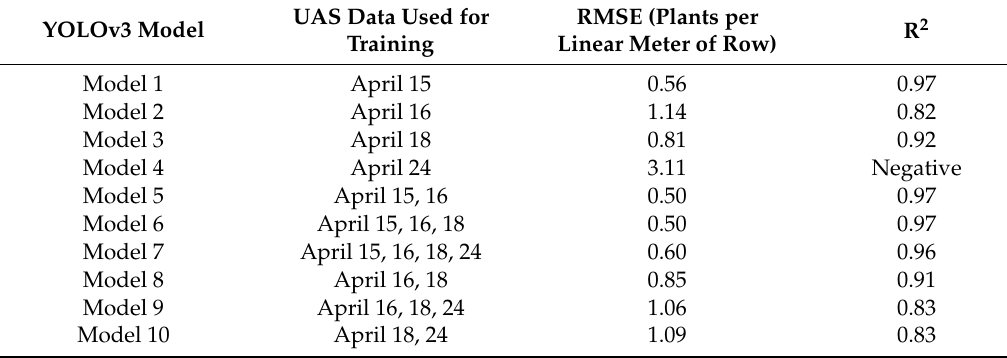
Table 5. RMSE and R 2 of UAS-based plant counting when class confidence score, maximum radial distance, and cluster distance threshold were set to 25%, 1980 pixels, and 0.10 m 2 , respectively. UAS Data Used YOLOv3 Model